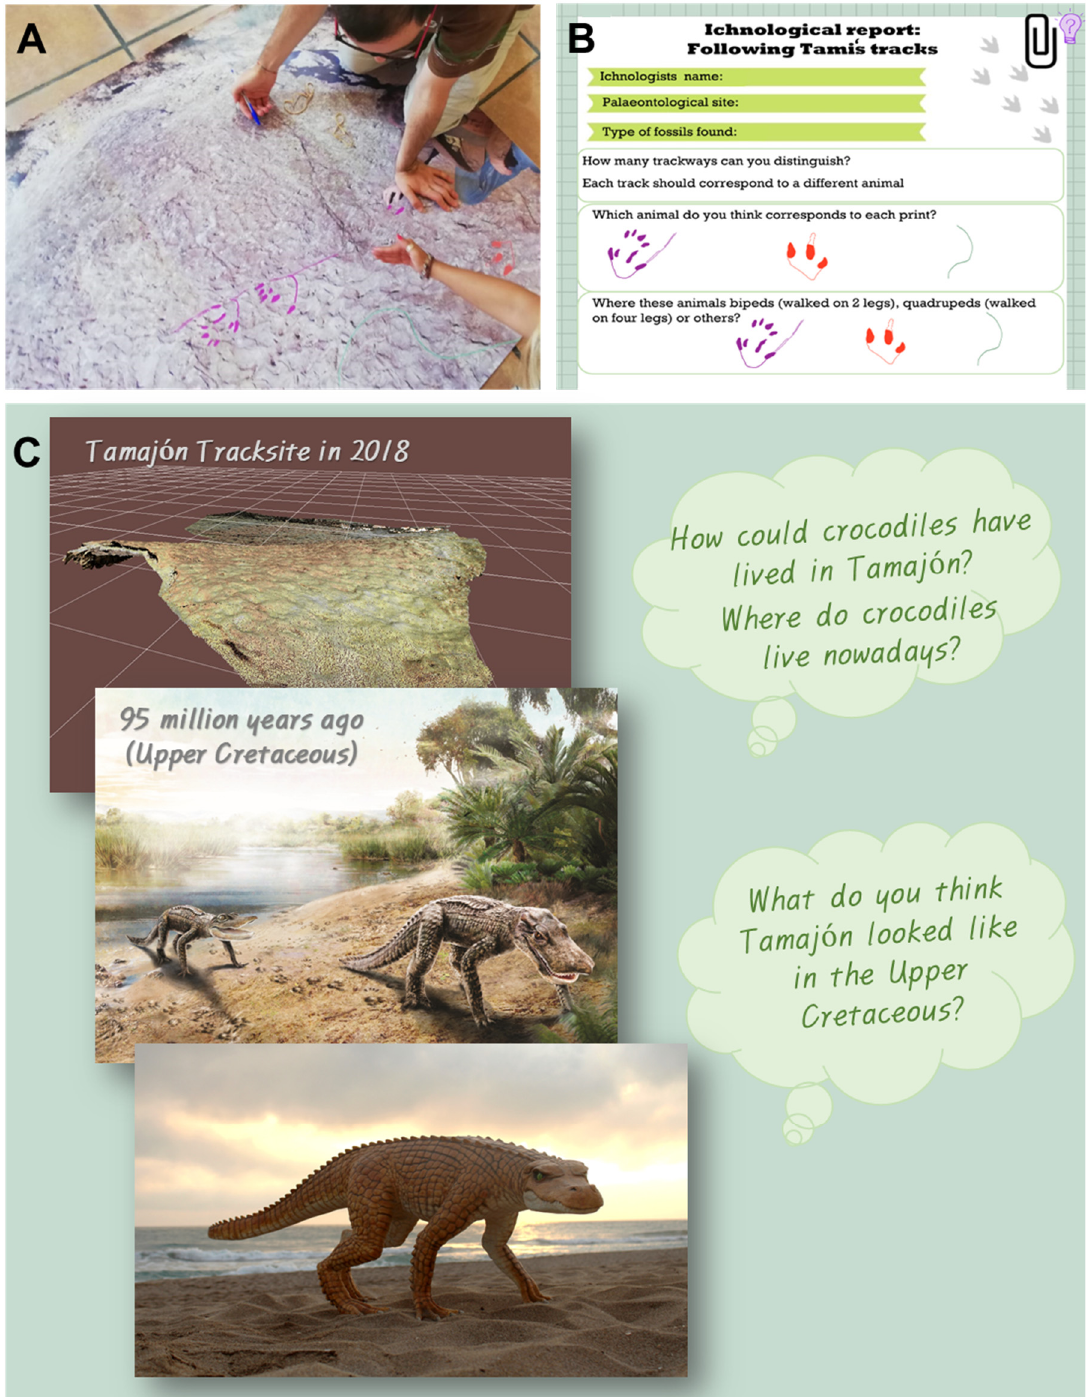
Figure 8. Examples of some of the proposed didactic activities. ( A ) Track surface mat for the